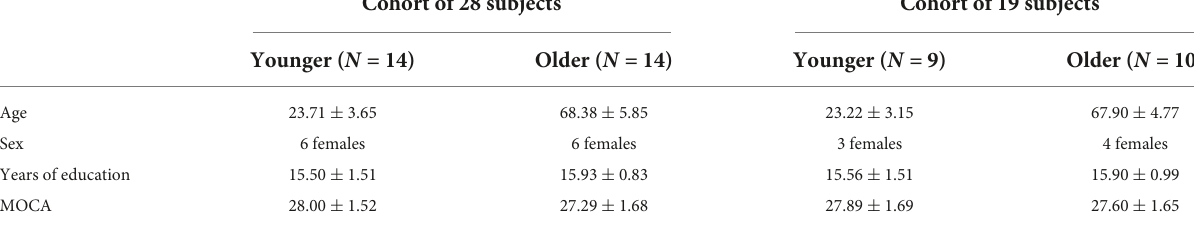
TABLE 1 Participant demographics for the cohort of N = 28 and the diminished cohort of N =